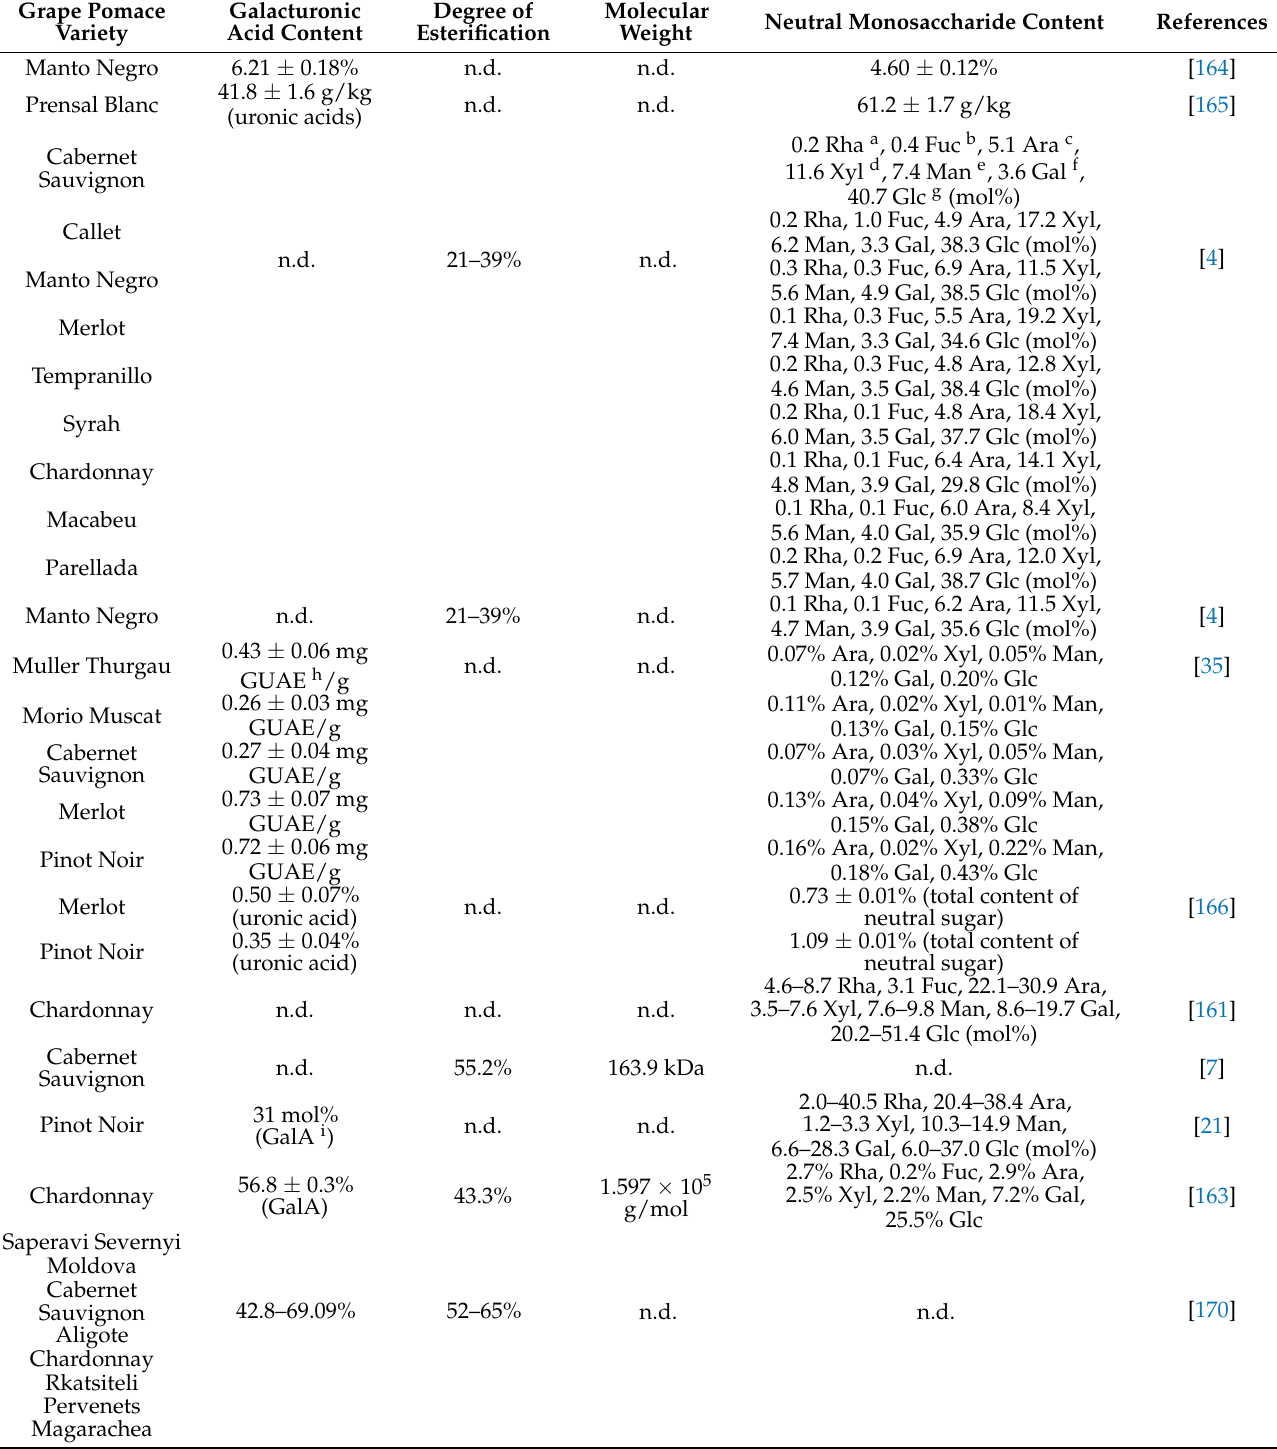
Table 5. Physico-chemical properties of grape pomace